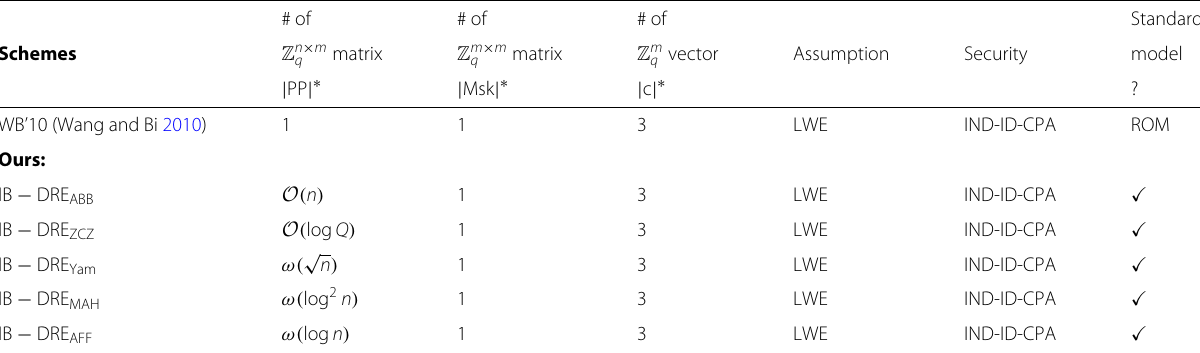
Table 2 Comparison of IB-DRE Schemes from